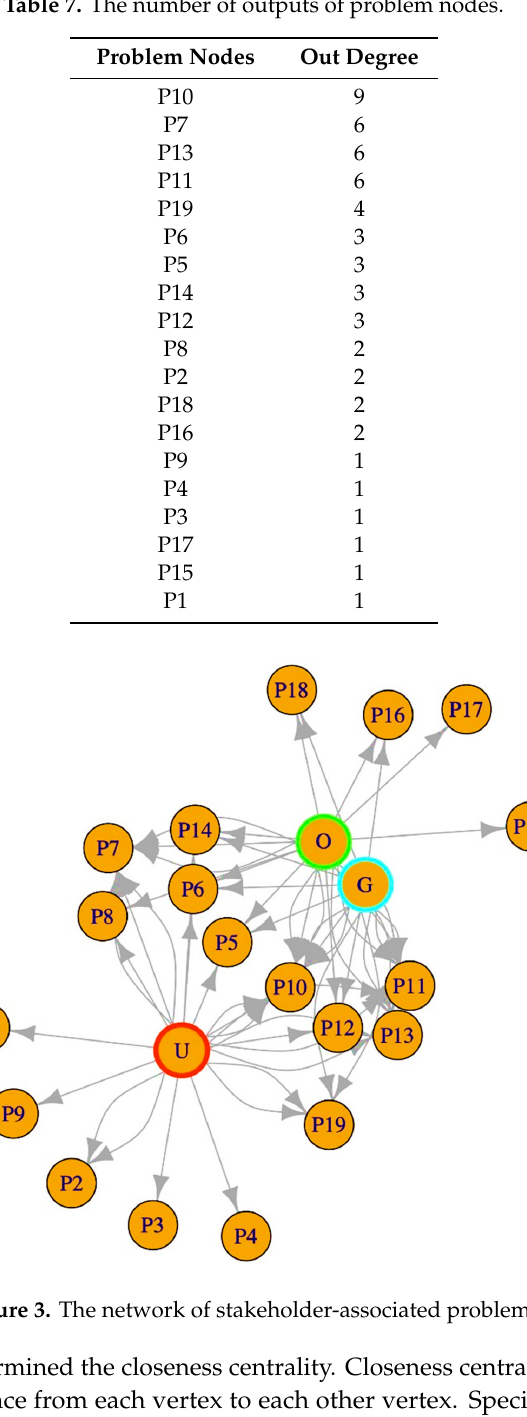
Table 7. The number of outputs of problem nodes.